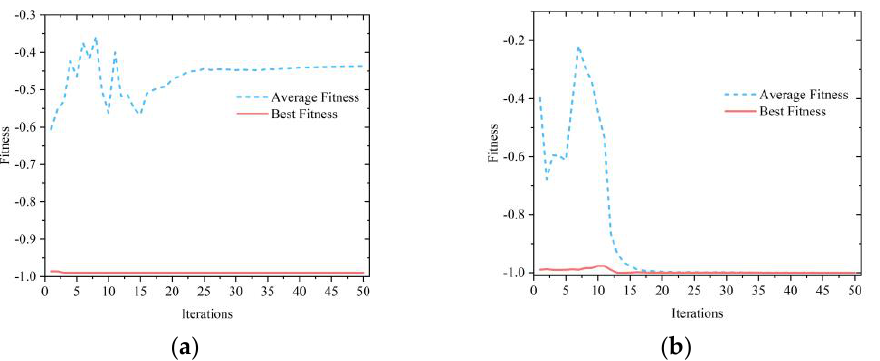
Figure 3. Evolutionary curve of the Schaffer function using different compensation models: ( a ) FA; ( b ) IFA.